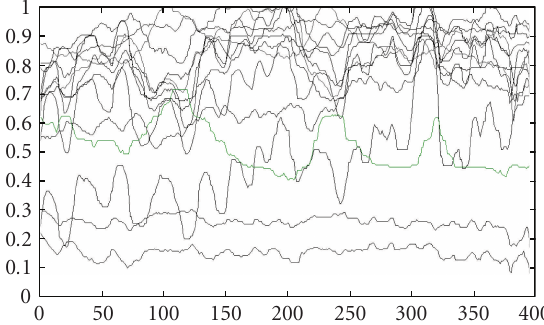
Figure 2.2 . Signals from 14-electrode